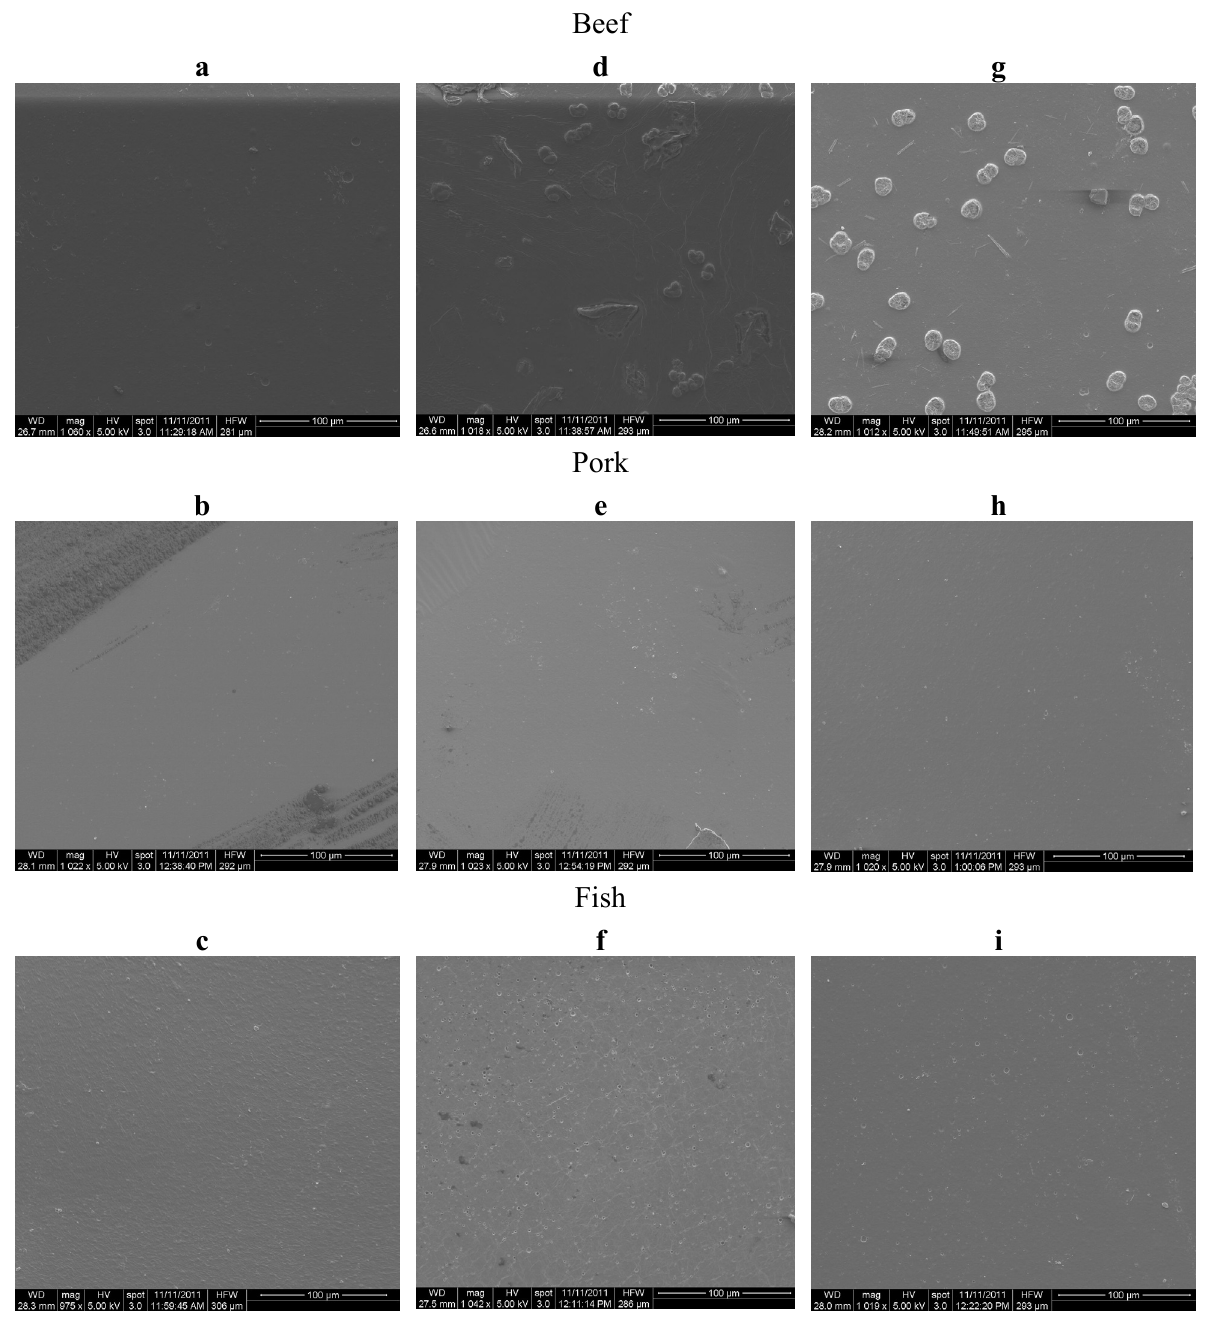
Figure 1. SEM images of composite films derived from beef, pork and fish gelatin sources with the concentrations of 4% ( a – c ), 6% ( d – f ) and 8% ( g – i